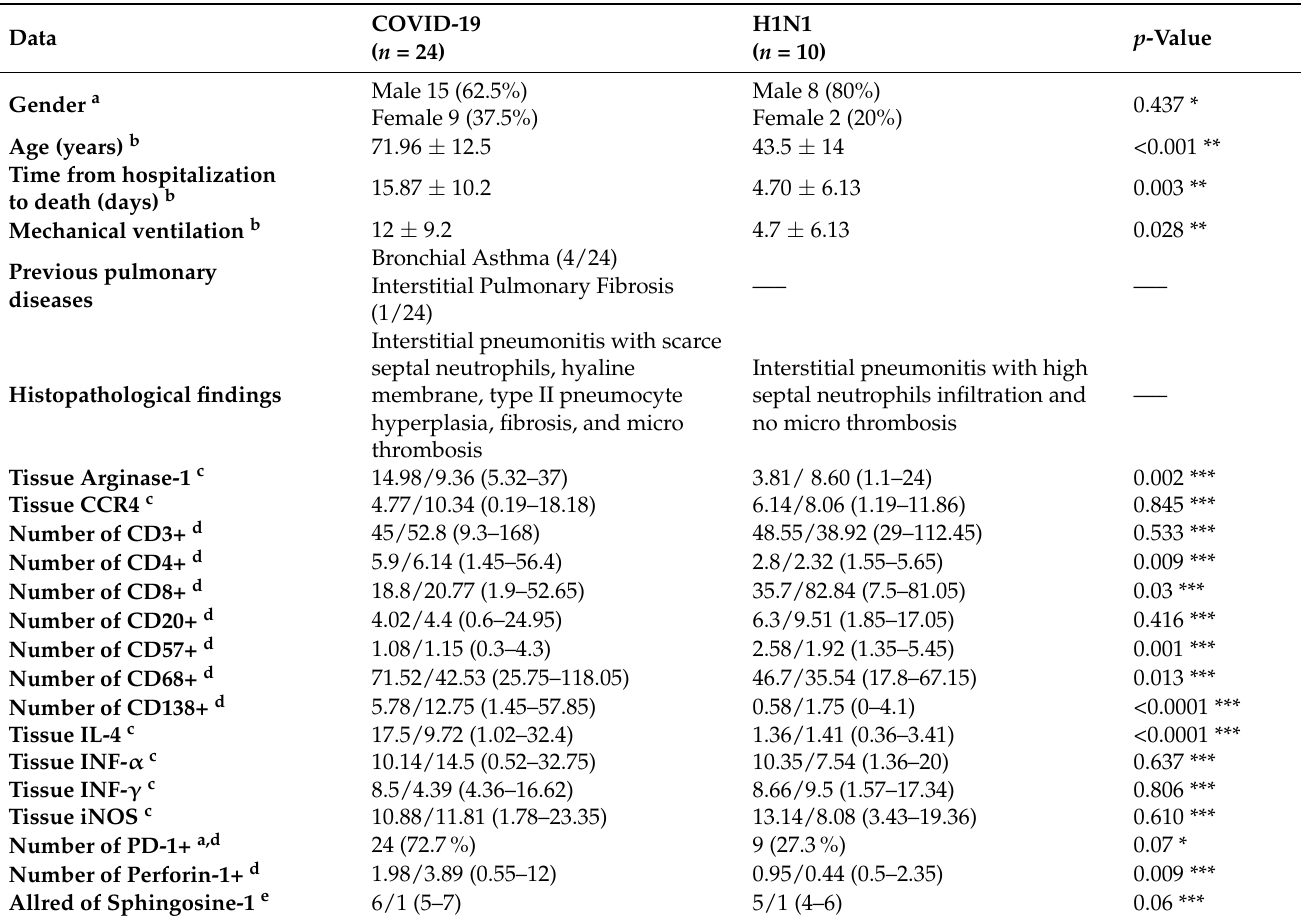
Table 1. Comparison between COVID-19 and H1N1 groups according to demographic, clinical, histopathological and immunohistochemistry